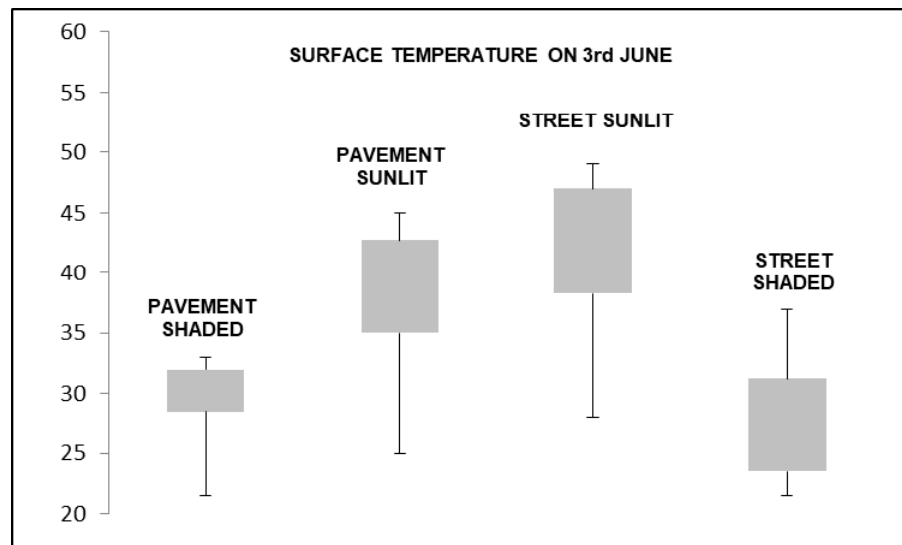
Figure 7. Surface temperature measured on sunlit and shaded pavement/asphalt/on the 3rd of June.